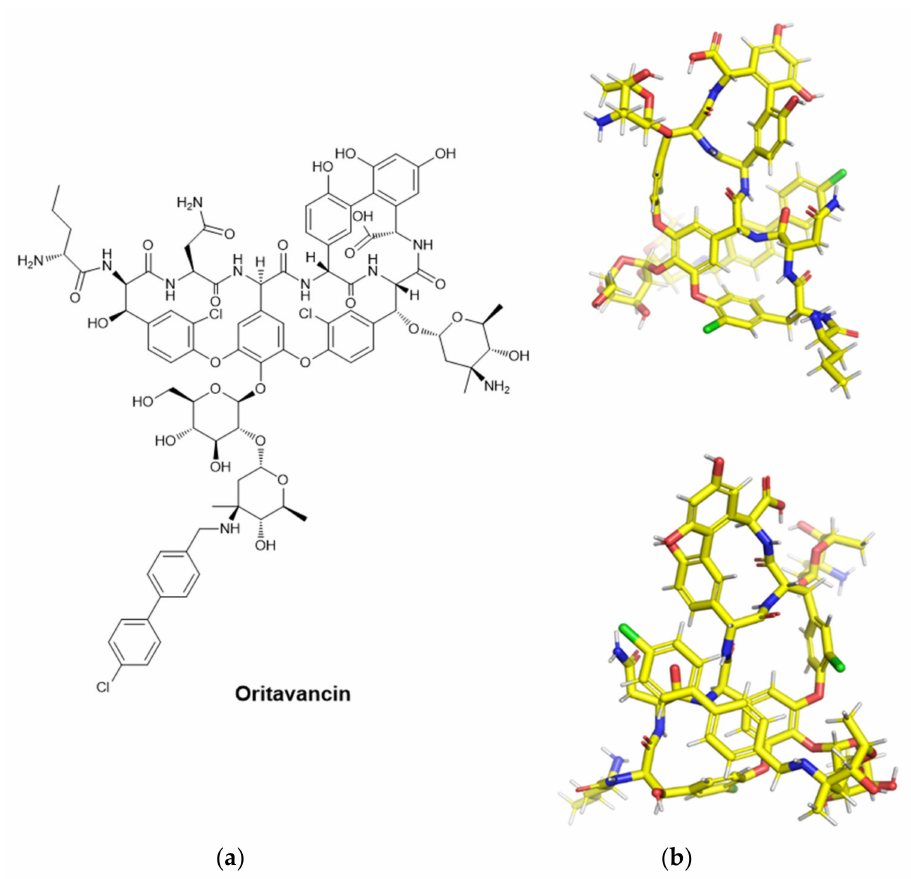
Figure 10. ( a ) 2D representation of oritavancin; ( b ) 3D energy minimized structure of oritavancin (yellow), made with